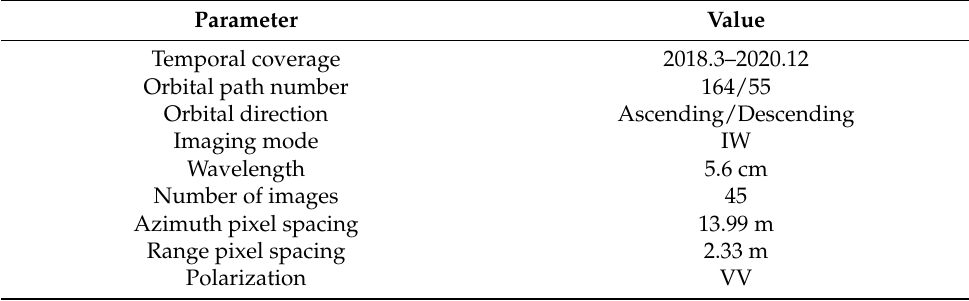
Table 2. Basic information of the Sentinel-1